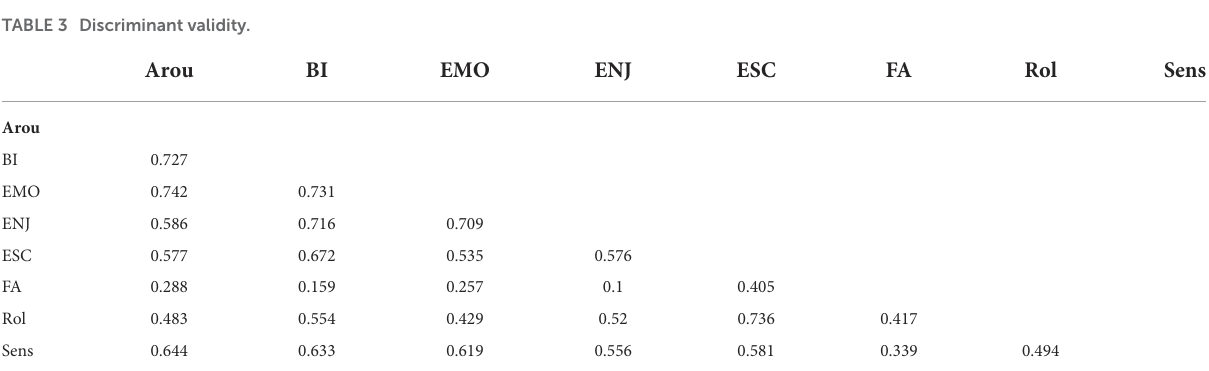
TABLE 3 Discriminant